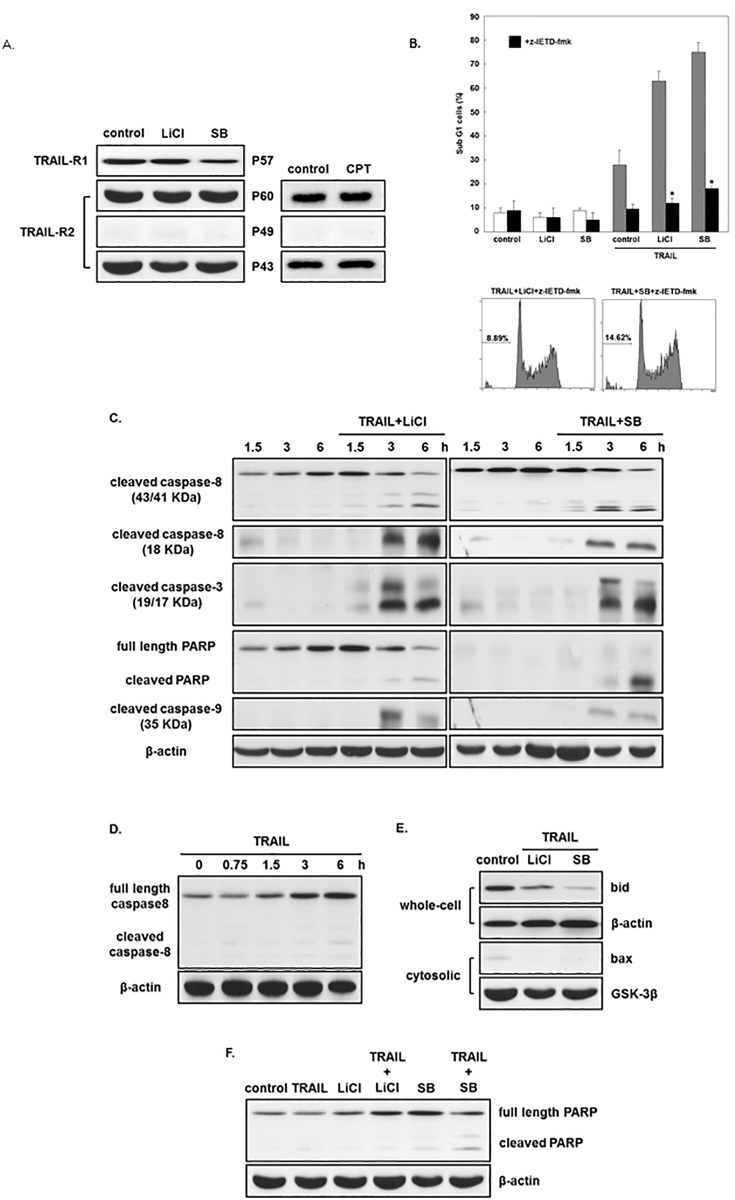
Sensitization effect of GSK-3 inhibitors requires enhancement of caspase-8 activity.(A) AGS cells were incubated with or without LiCl (20 mM) or SB (25 μM) for 24 hours. Western blot analysis of TRAIL-Rl and TRAIL-R2 expression of whole cell extracts (40 μg) was analyzed. AGS incubated with CPT (0.5μ M) for 12 hours served as a positive control (camptothecin) for upregulation of TRAIL-R2. (B) Blots are representative of four independent experiments and the quantified values are the mean ±the standard error (SE) of four independent experiments. The statistical significance was determined by comparing with AGS treated with LiCl/TRAIL or TRAIL/SB-415286, *, p < 0.01. AGS incubated with or without TRAIL (25 ng/mL), LiCl (20 mM), SB (25 μM) and or z-IETD-fmk (caspase-8 inhibitor, 20 μM) for 24 hours. Then Sub-G1 cells were analyzed by flow cytometry. (C and D) AGS were incubated with or without TRAIL (25 ng/mL), LiCl (20 mM) or SB (25 μM) for 0.75, 1.5, 3 and 6 hours. Caspase-8, -3, -9 and PARP-cleaved in AGS whole extracts were evaluated by Western blotting. (E) AGS were incubated for 6 hours with or without TRAIL (25 ng/mL), LiCl (20 mM) or SB (25 μM). The AGS whole extracts were analyzedfor bid expression and evaluated for bax expression in cytosolic extracts by Western blotting. Replication was performed with GSK-3β and β-actin Abs to confirm equivalent loading. (F) AGS were treated with or without TRAIL (25 ng/mL), LiCl (20 mM) or SB (25 μM) for 6 hours. AGS whole extracts were evaluated for PARP cleavage by Western blotting.